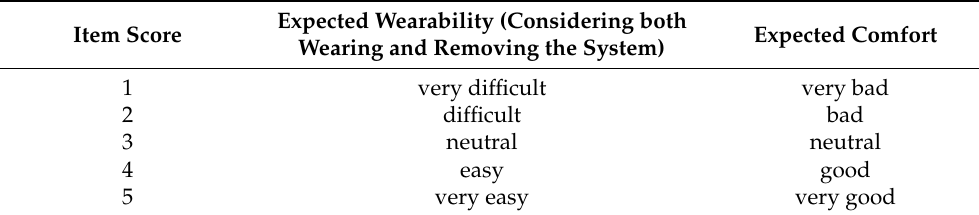
Table 2. Scoring table for the pre-test questionnaire for the factors with their semantic meaning and the corresponding value of 1–5 in the Likert scale